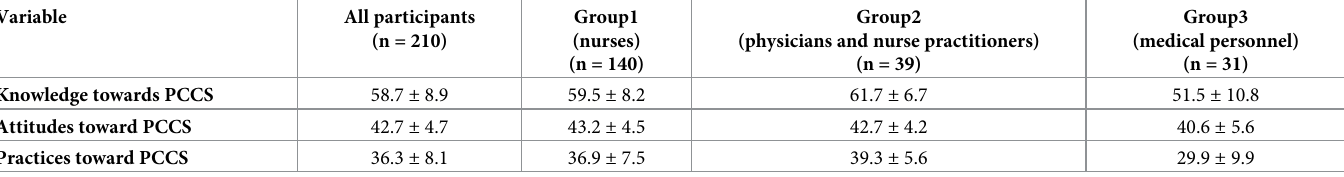
Table 2. Knowledge, Attitudes, and Practices toward PCCS.